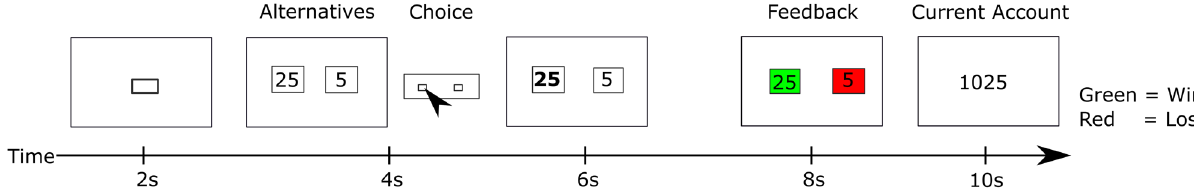
Figure 3. Depiction of the procedure of the gambling task adapted by us from Gehring and Willoughby 42 . This figure was created using Inkscape 50 (Version 0.92; www. inksc ape.